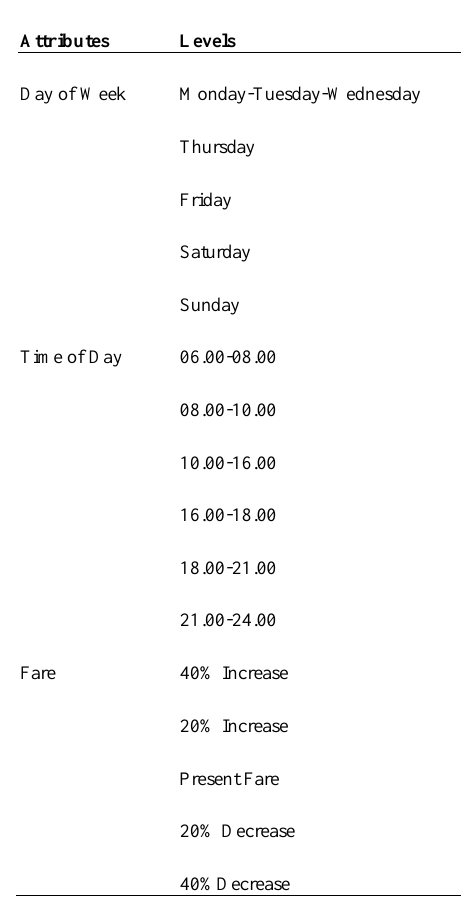
Table 1. Attributes and attribute levels of ferry